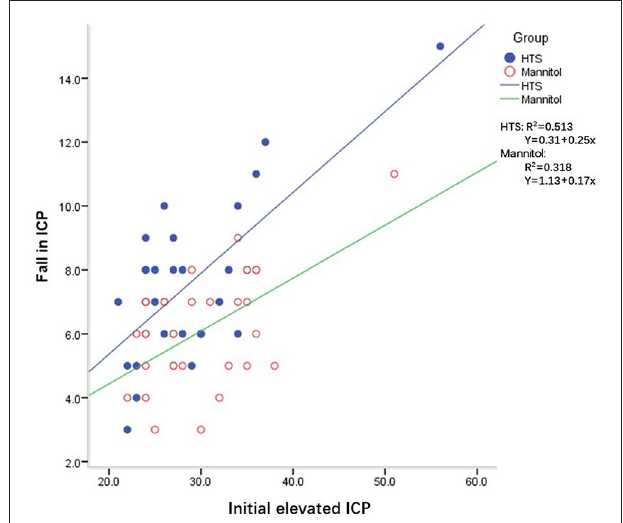
FIGURE 1 | Intracranial pressure (ICP) reduction for a given ICP value with mannitol and hypertonic saline (HTS) in patients with traumatic brain injury after decompressive